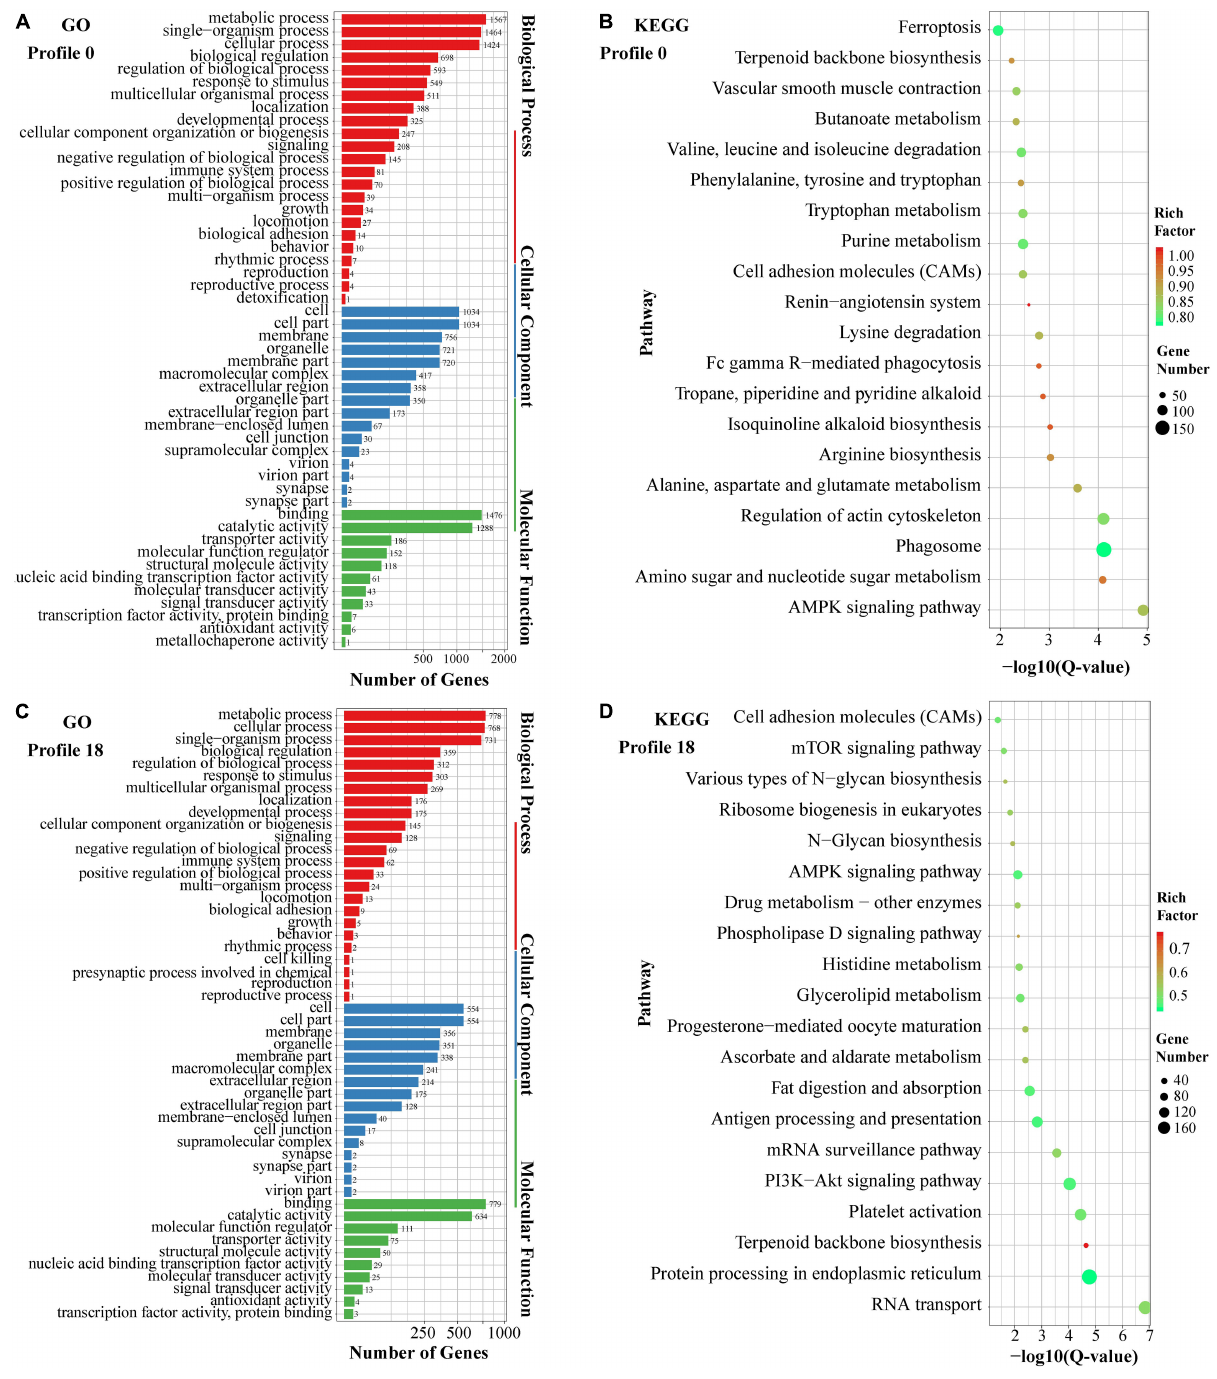
NIPSNAP1 , and MAF1 were down-regulated and